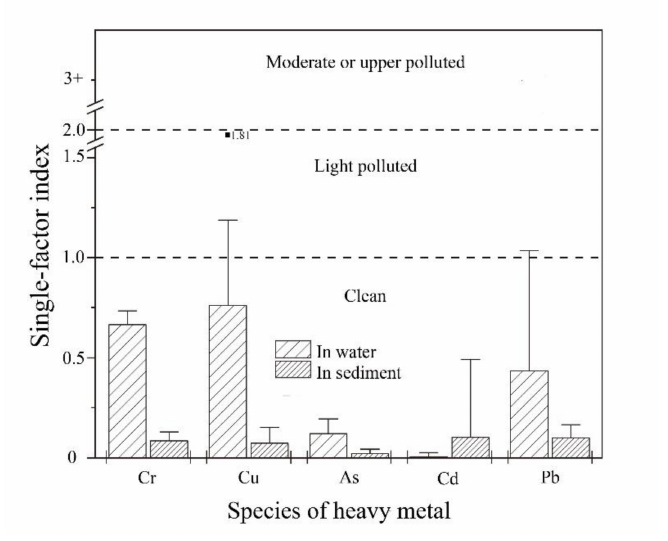
Figure 4. Evaluation of the single-factor